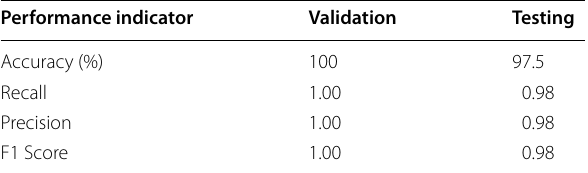
indicators calculated from the classification of CWT images of undamaged and